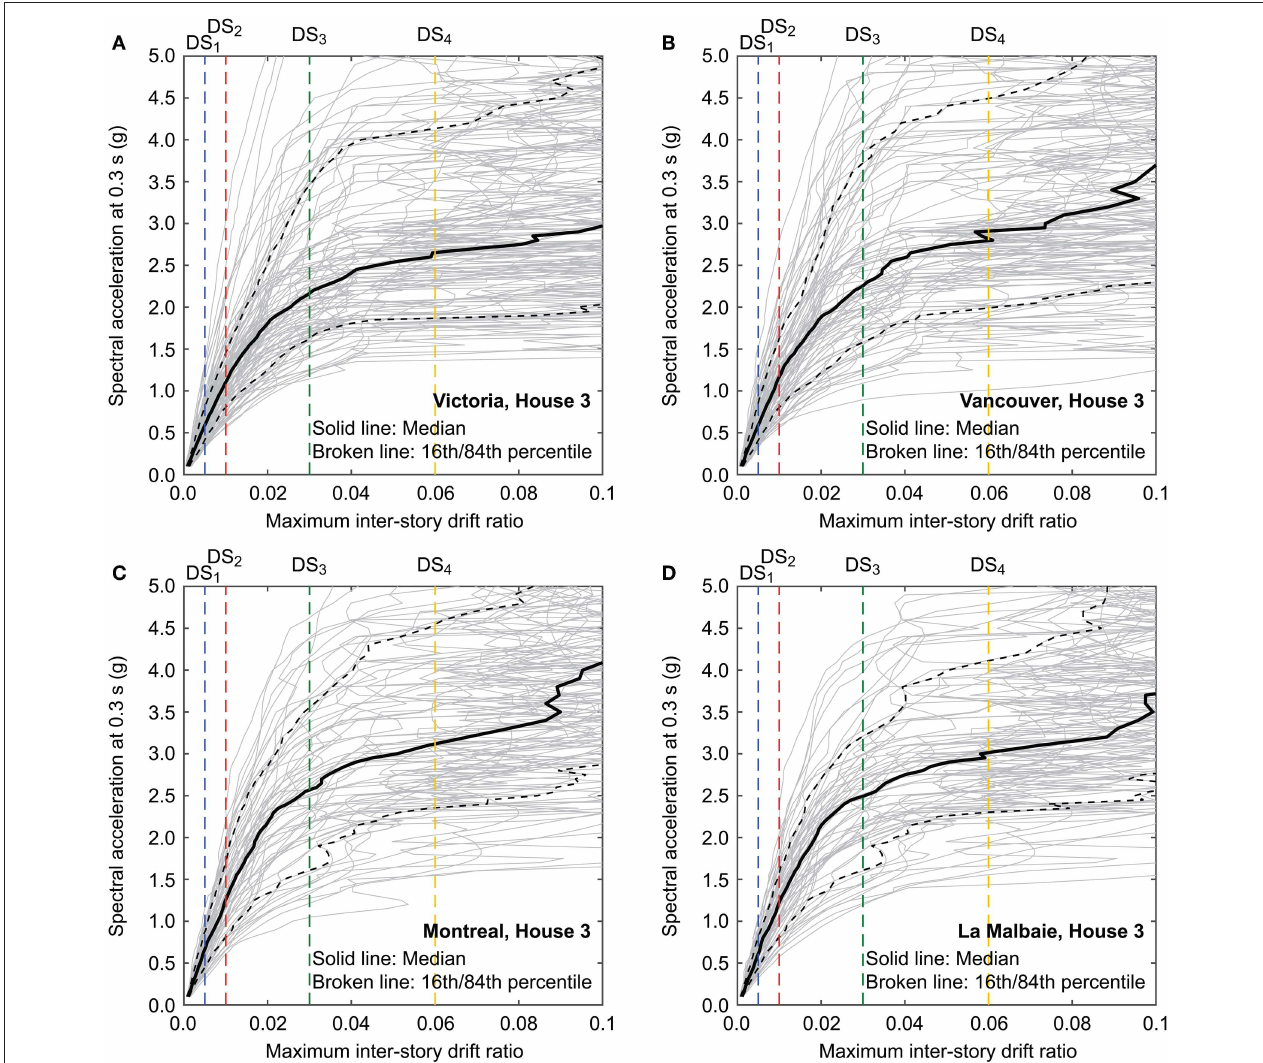
FIGURE 8 | Incremental dynamic analysis results for House 3: (A) Victoria, (B) Vancouver, (C) Montreal, and (D) La Malbaie.